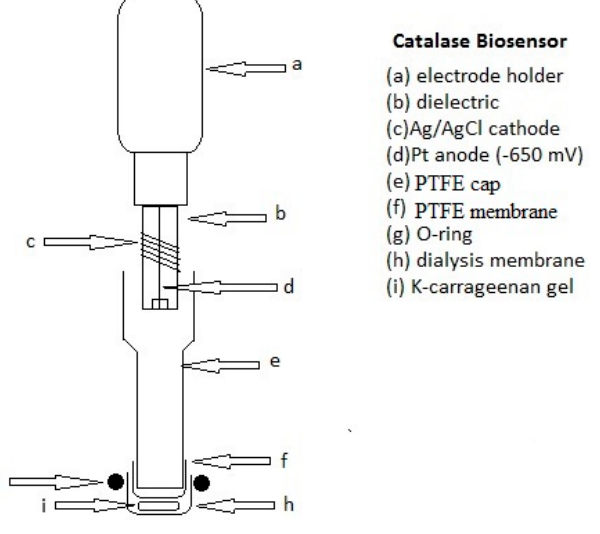
Figure 1. Catalase biosensor assembly.